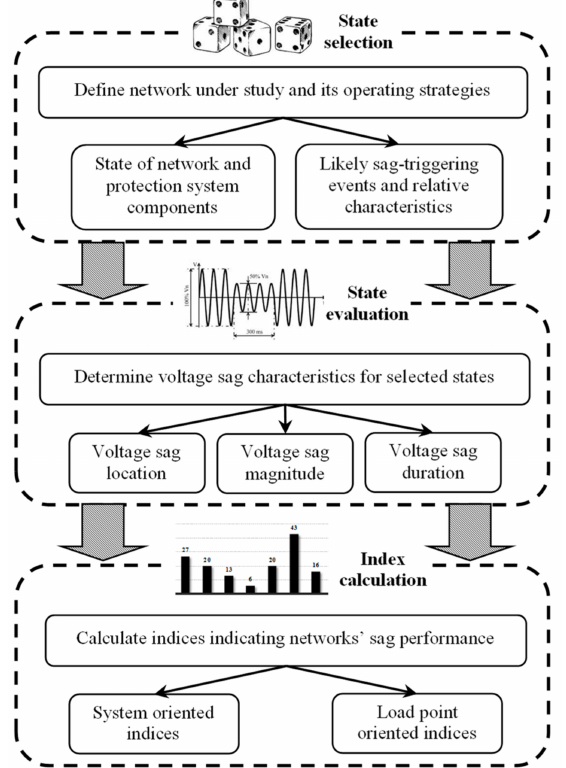
Figure 1. Three steps of voltage sag performance